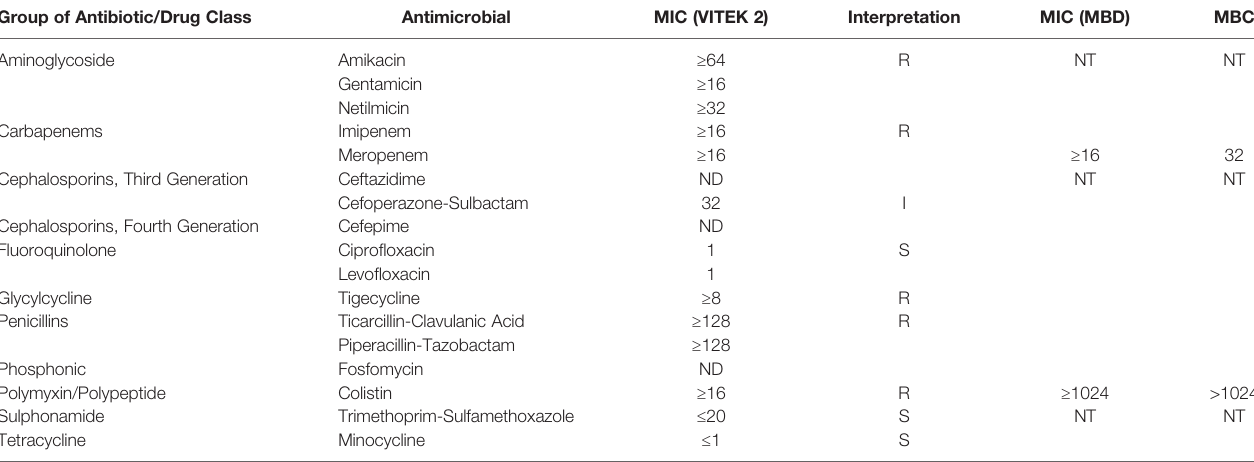
TABLE 1 | Antimicrobial susceptibility testing using VITEK 2 system and micro-broth dilution – based MIC and MBC of C. gallinarum MGC42. Group of Antibiotic/Drug